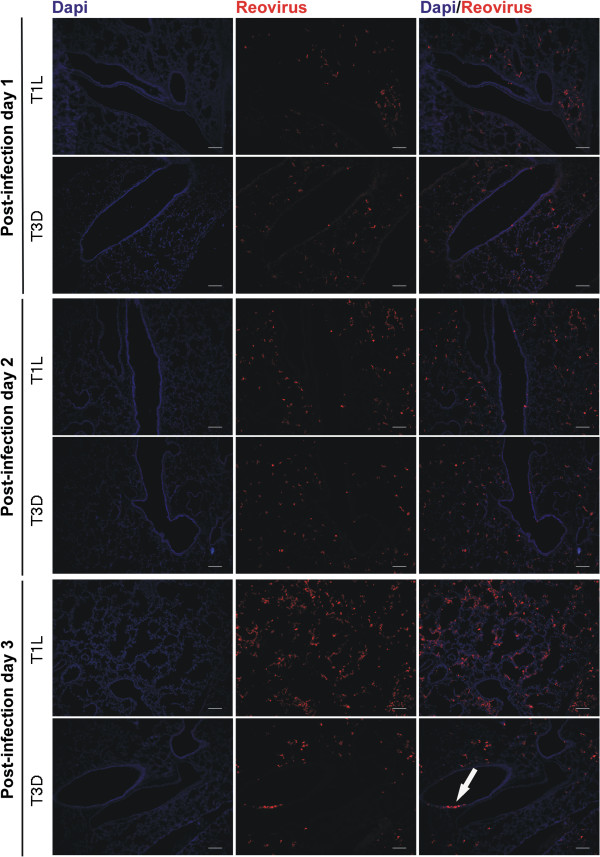
Time course of immunofluorescent staining of virus infected suckling lung. Two day old suckling mice were infected intranasaly with 105 pfu of either T1L or T3D before fluorescent antibody staining of frozen lung sections after 1, 2, or 3 days of infection. T1L and T3D antigens were stained with virus specific antiserum as described in Figure 5. Cell nuclei were stained with DAPI, shown in blue. Size bars are 100 μM. Sagital sections show viral infection patterns similar to those of adults ( Figures 5 and 6) that again show sparse staining of epithelium in the bronchiolar airways (arrow) being restricted primarily to T3D infection.